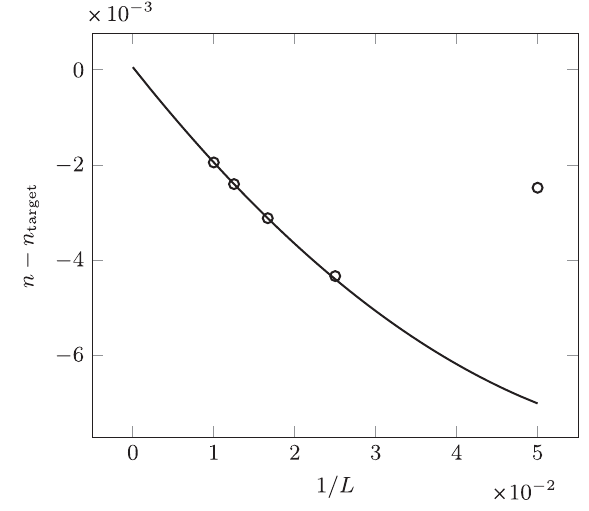
FIG. 9. Example of excited-state density extrapolated to infinite system size for U ¼ − 2 t , t ⊥ ¼ 0 . 08 t , and density n